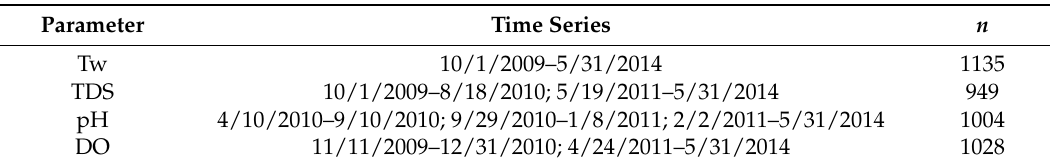
Table 2. Time series and sample size ( n ) for stream physiochemical parameters measured during study period (October 2010–May 2014) in Hinkson Creek Watershed, MO,